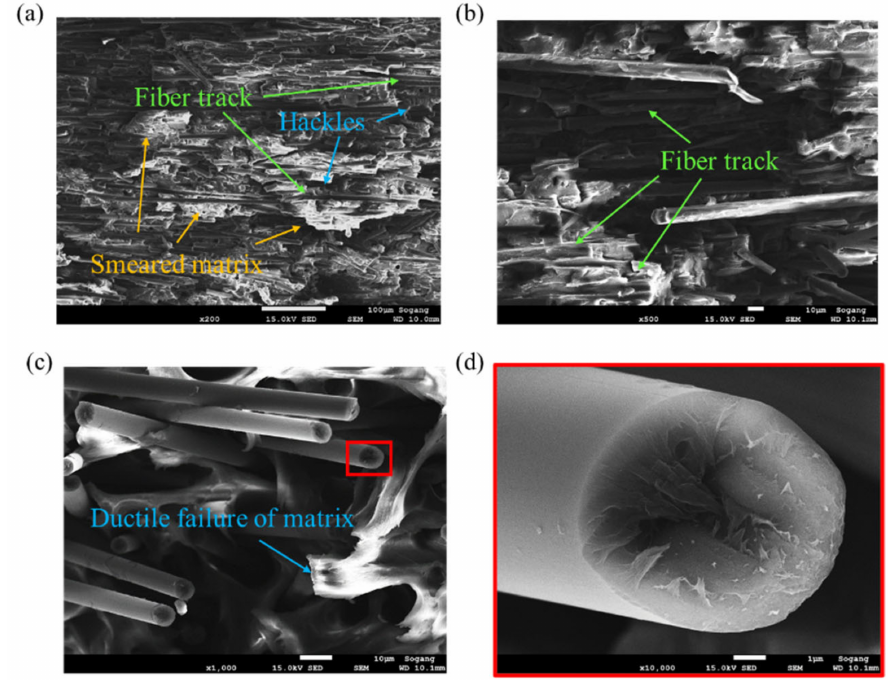
Figure 11. Fracture mechanisms observed for θ = 90 ◦ tensile specimen: ( a ) Fiber tracks, hackles, and smeared matrix (magnification: × 200, scale: 100 µ m), ( b ) fiber tracks and broken long fiber (magnification: × 500, scale: 10 µ m), ( c ) ductile failure of the matrix (magnification: × 1000, scale: